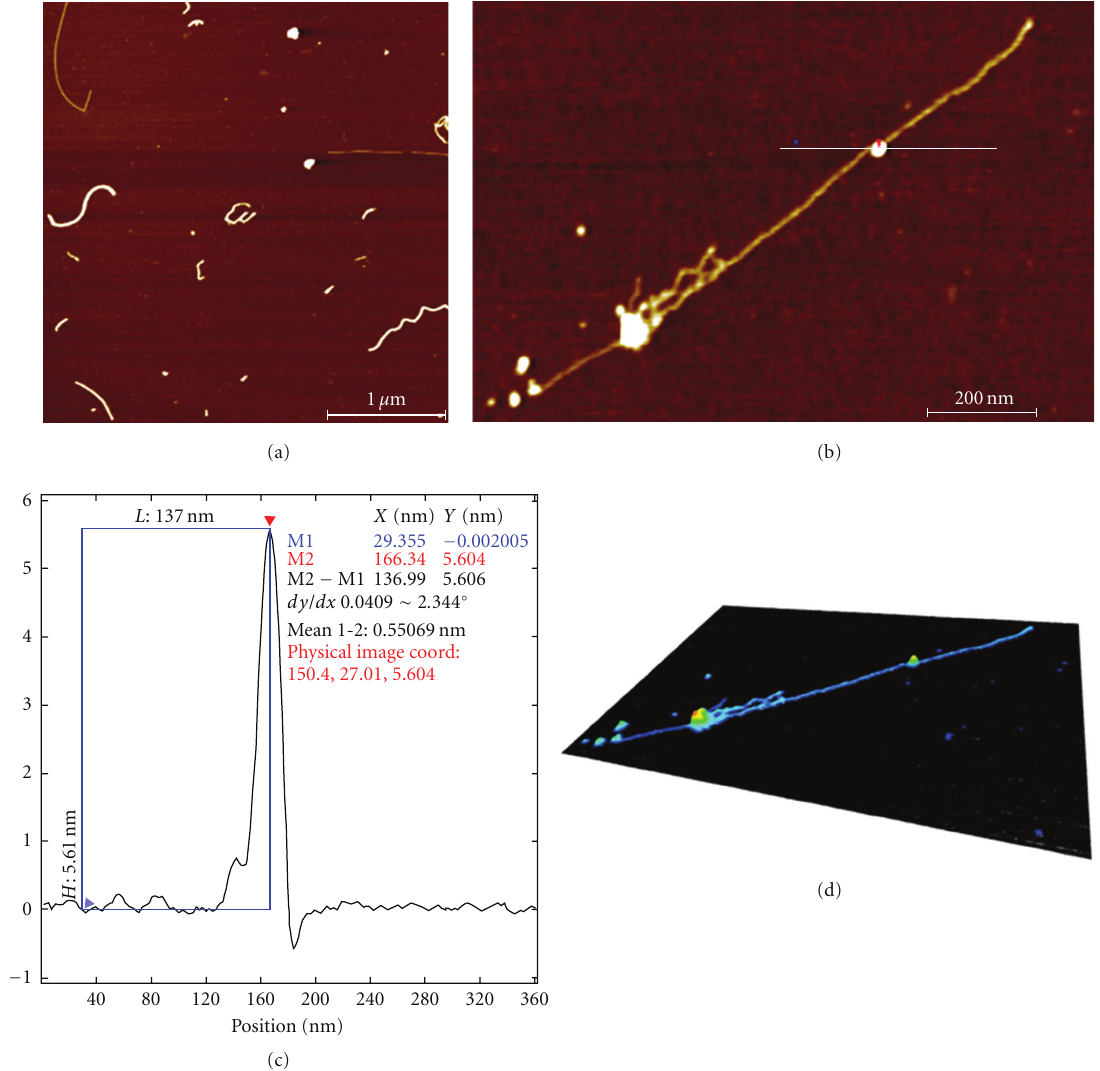
Figure 3: AFM topography images of (a) SWCNT and (b) Ag-treated SWCNT. SWCNT sample shows the presence of individual SWCNT and bundled SWCNTs. (c) Line profile from (b) of Ag nanoparticle on the surface of SWCNT. (d) 3D topography image of (b).